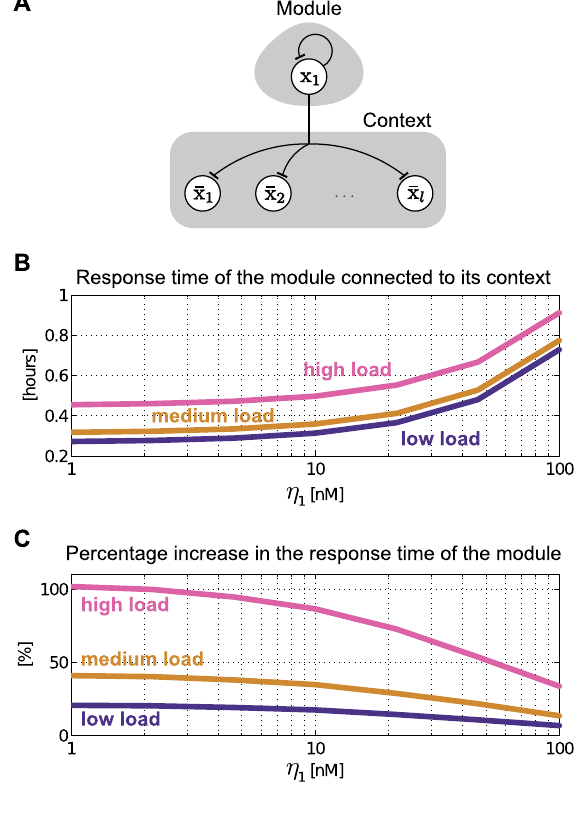
Figure 8. Internal retroactivity makes a module more robust to interconnection at the expense of speed. (A) The module consists of a single negatively autoregulated node, whereas the context comprises l nodes repressed by the TF in the module. (B) The internal retroactivity R of the module increases with the DNA copy number g 1 of x 1 . As a result, the module becomes slower as R increases. (C) The percentage increase in the response time of the module decreases with g 1 , that is, internal retroactivity R increases the robustness to interconnection. Simulation parameters: d 1 ~ 1hr { 1 , k 1 ~ 10nM and p 1,0 is changed such that x 1 ~ 50nM at the steady state. The context contains l nodes each with DNA concentration (cid:2) gg i ~ 1nM for i ~ 1,2, ... , l (low load: l ~ 10 ; medium load: l ~ 20 ; high load: l ~ 50 ). The response time is calculated as the time required to reach 50% of the steady state value.